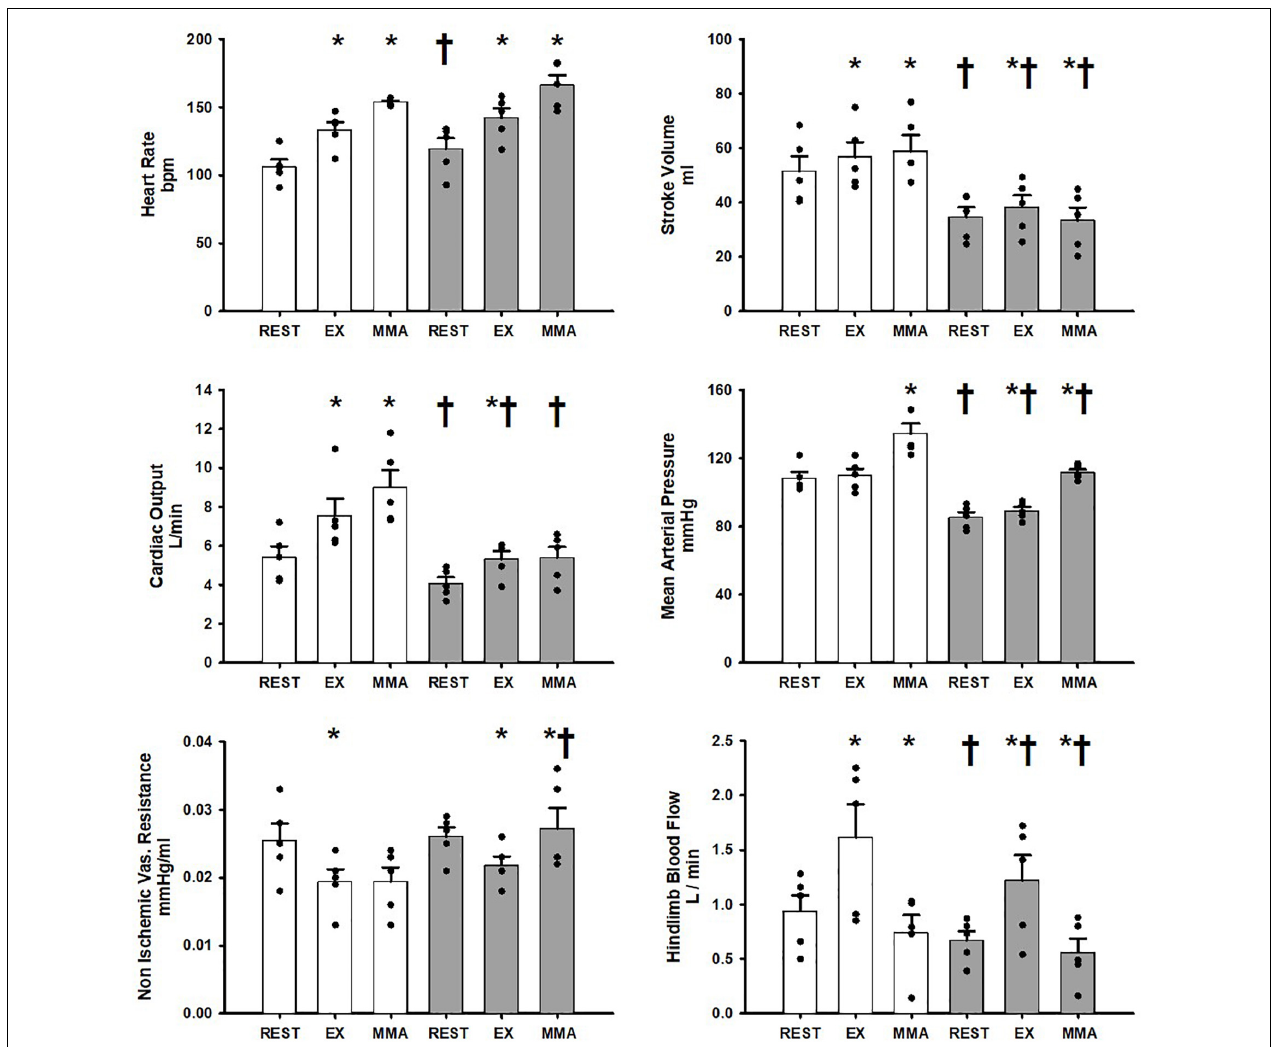
FIGURE 1 | Average 1-min steady state hemodynamics from the Control group at rest, exercise (EX), and exercise with muscle metaboreflex activation (MMA) before (white) and after induction of heart failure (gray). Data are reported as means with standard error. Observed data points are overlain on corresponding bar graphs. Statistical significance vs. previous workload is depicted as * and vs. previous condition as † where P < 0.05. ( N = 5). significantly reduced in the transition from rest to